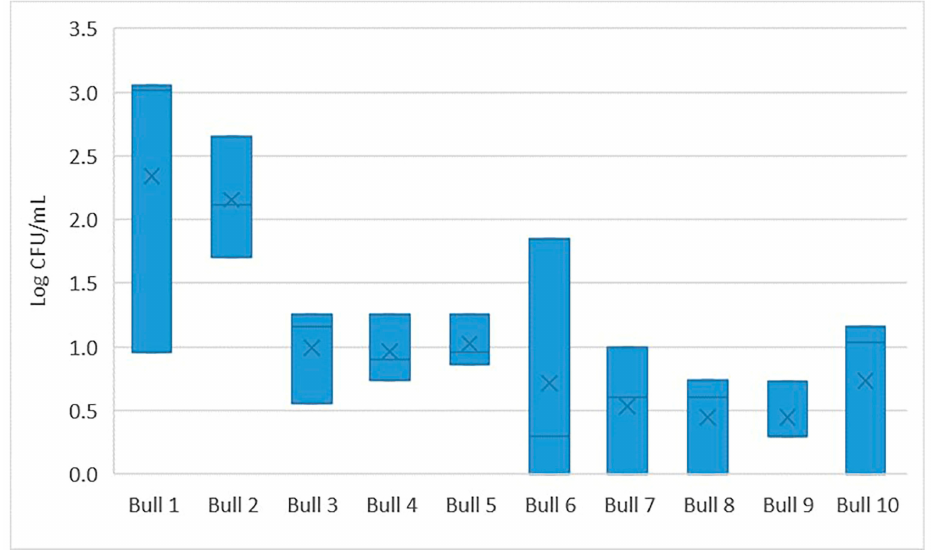
Figure 2. Number of bacteria (Log CFU/mL) in control samples ( n = 3) for individual bulls at Time